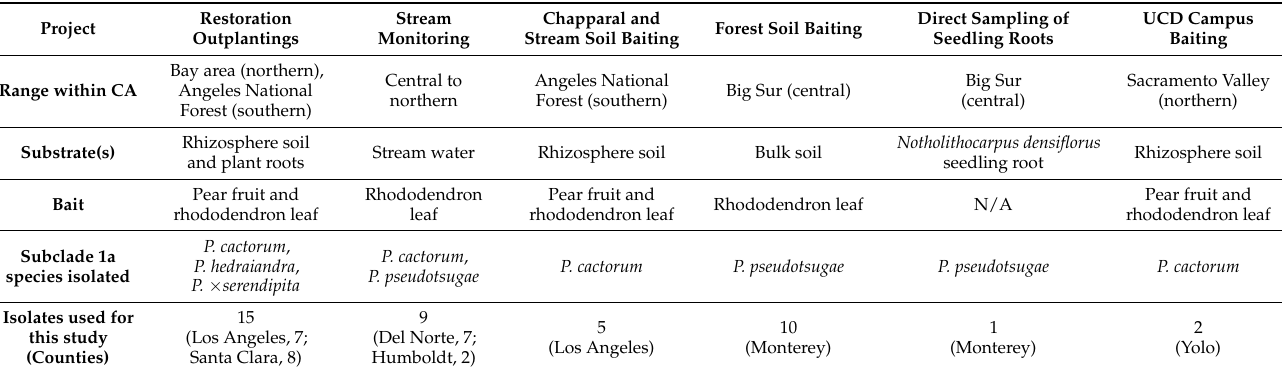
Table 1. List of projects from which the 42 California Phytophthora isolates were